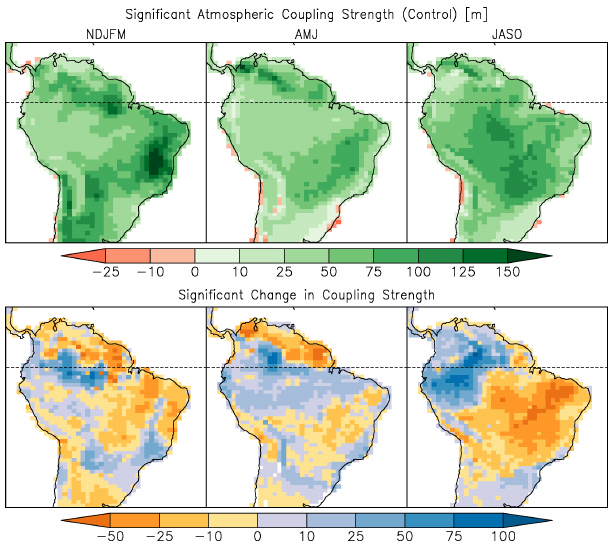
Figure 9. Atmospheric leg of coupling strength (m) between sen- sible heat flux and planetary boundary layer height for the control simulation (top row) and change due to deforestation (bottom row) for NDJFM, AMJ and JASO. Shading indicates significance of the correlation component at the 95% confidence level.